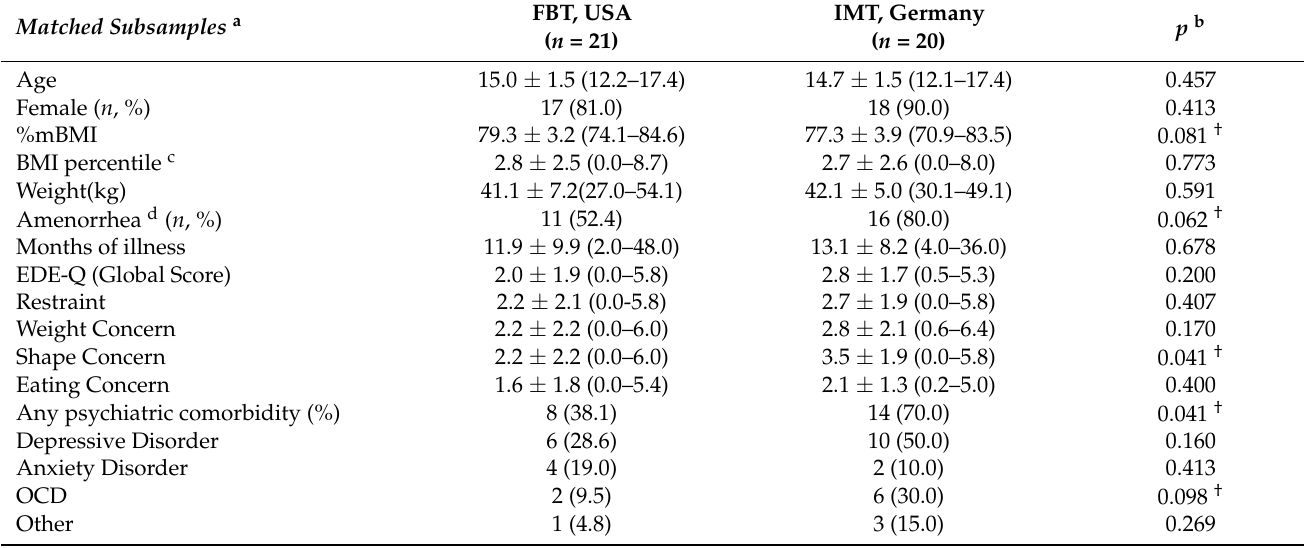
Table 4. Group differences at baseline in eating disorder and general psychopathology in the FBT and IMT subsamples after applying the second set of inclusion